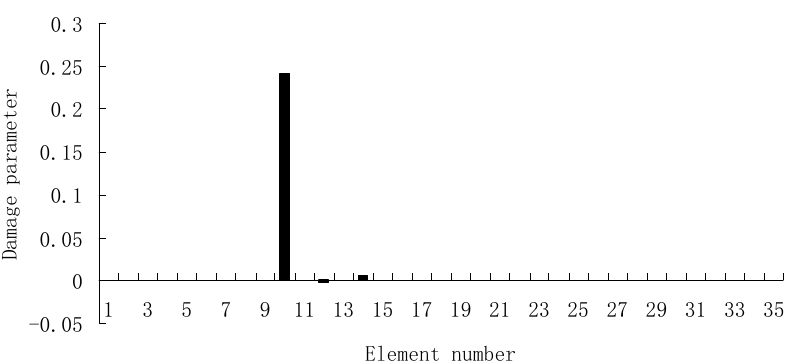
Figure 6. Damage evaluation result by the third computation of ESVT for case 1 (element 10 had 20% stiffness reduction).